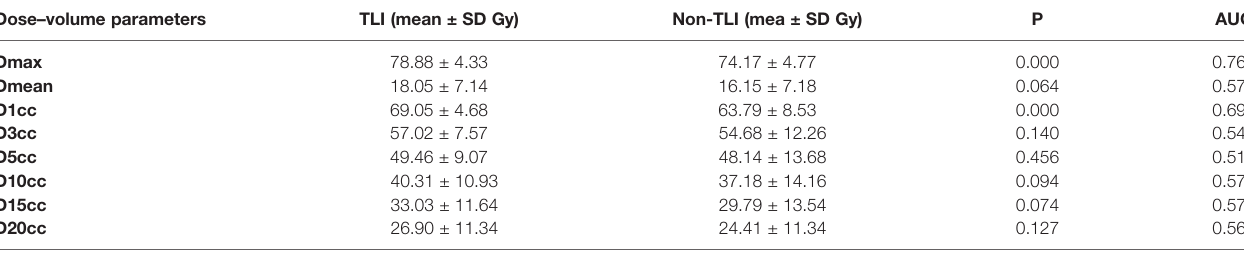
TABLE 2 | Dose – volume parameters of radiation temporal lobe injury in primary cohort.